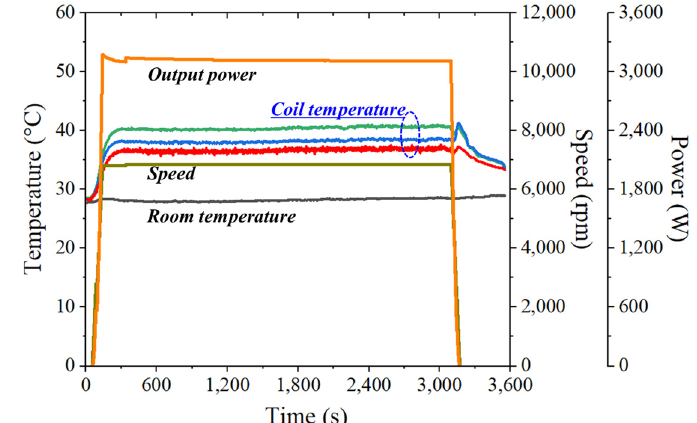
13 of 15 ( c ) Figure 14. No-load and load test results according to speed and load resistance: (a) No-load test; (b) 2-ohm/phase resistance load test; and (c) 1-ohm/phase resistance load test.